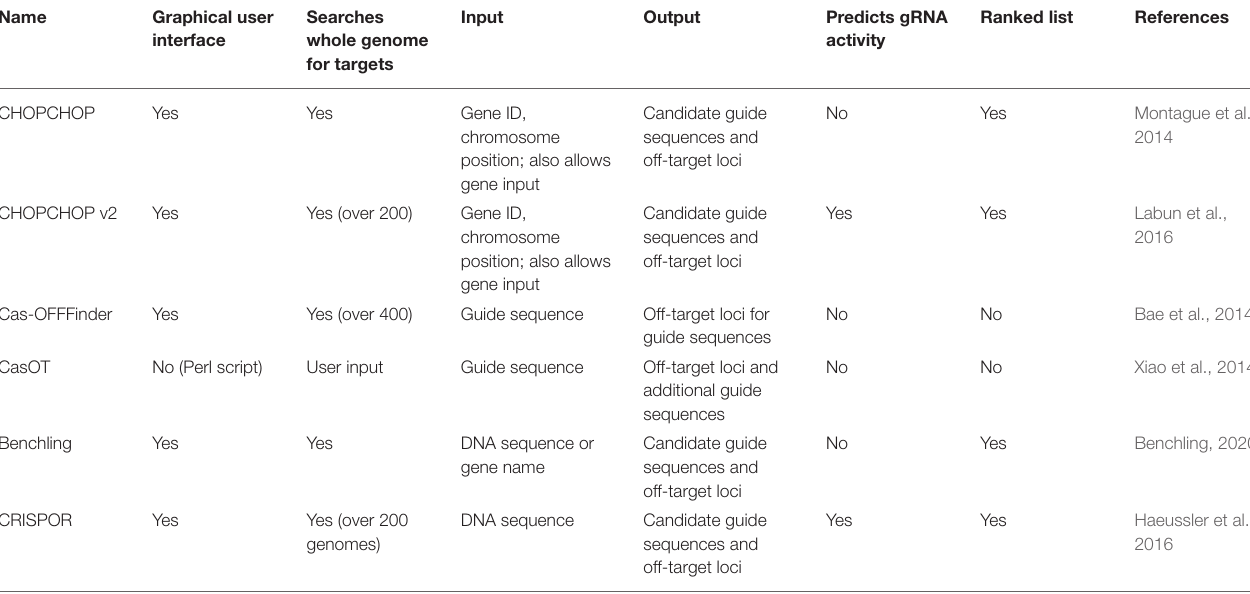
TABLE 3 | List of existing free online tools and open-source local software for sgRNA